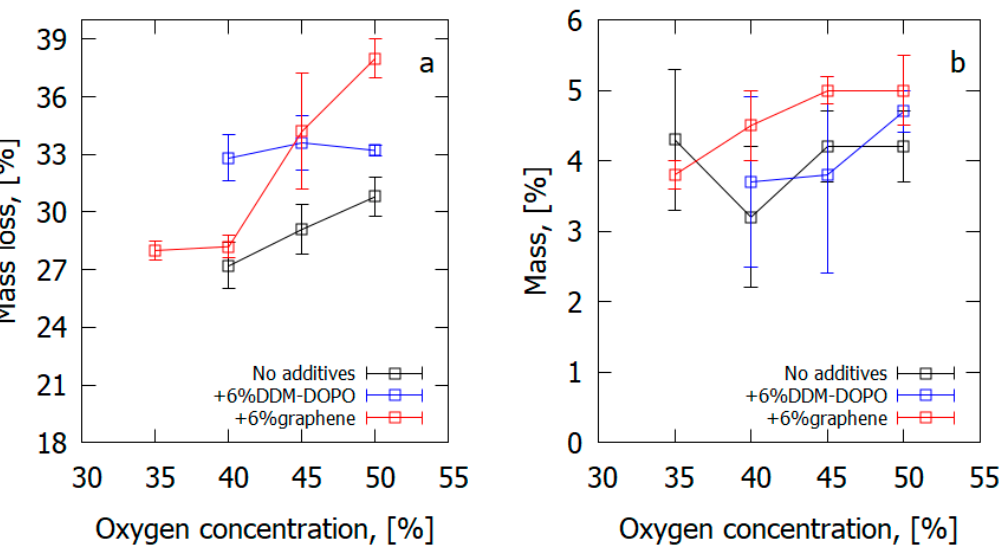
Figure 26. (a) The measured total mass loss of a sample after the experiment and (b) the mass of Figure 26. ( a ) The measured total mass loss of a sample after the experiment and ( b ) the mass of soot soot collected from the sample surface after the experiment. collected from the sample surface after the